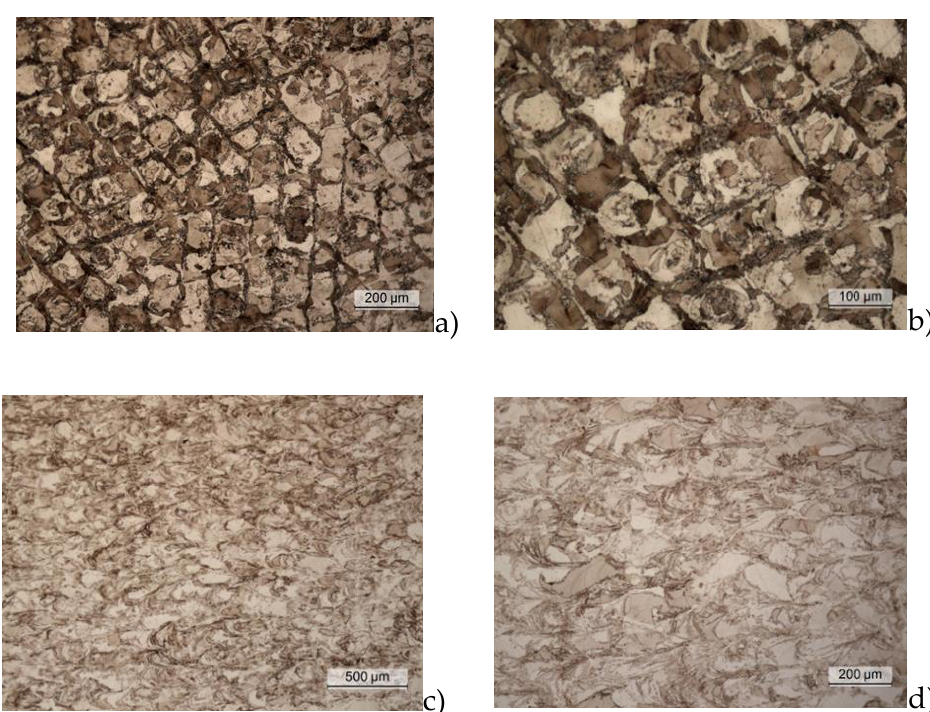
Figure 8. Melt pools in the transversal direction ( a , b ) and in the build direction ( c , d ). In Figure 9, the crack path was compared with the tooth microstructural features. It is clearly visible that the propagation direction is not influenced by the melt pool boundaries, but it is instead completely inside the pools.